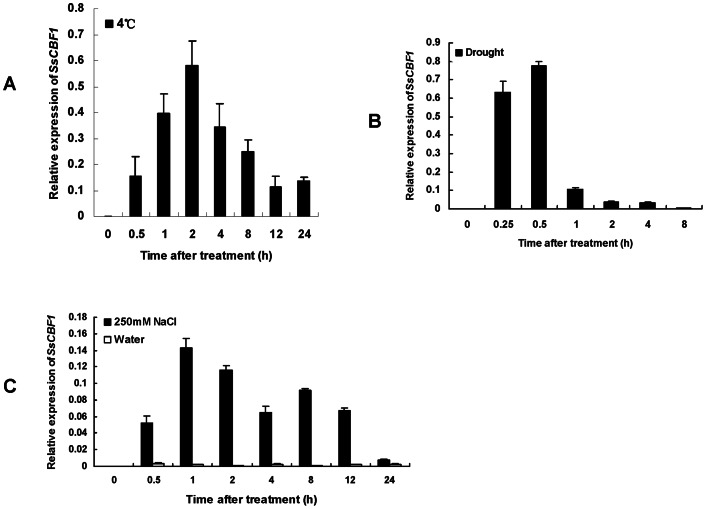

SsCBF1 transcript levels in response to various abiotic stresses.(A) Low-temperature induced expression pattern of SsCBF1 in S. lycopersicoides. S. lycopersicoides seedlings grown under standard conditions were transferred to a climate chamber set at 4°C for a 24 time course under constant light. The aerial parts were harvested for RNA extraction and qRT-PCR analysis. Zero time samples were taken prior to treatment. Transcript levels of SsCBF1 were normalized to the ACTIN2 expression. (B) Drought induced expression pattern of SsCBF1 in S. lycopersicoides. Detached young leaves of S. lycopersicoides were placed on a dry filter paper for drought treatment. Samples were collected according to the time course. The SsCBF1 mRNA levels were analyzed as in (A). (C) High-salinity induced expression pattern of SsCBF1 in S. lycopersicoides. Detached young leaves of S. lycopersicoides were placed on the filter paper soaked with NaCl solution (250 mM, 0.02% Tween-20) for a high-salinity treatment. Samples were collected at the indicated time points. The SsCBF1 mRNA levels were analyzed as in (A). Data shown are average and SD of triplicate reactions. Shown are representative data from one biological replicate and three biological replicates were conducted with similar results.